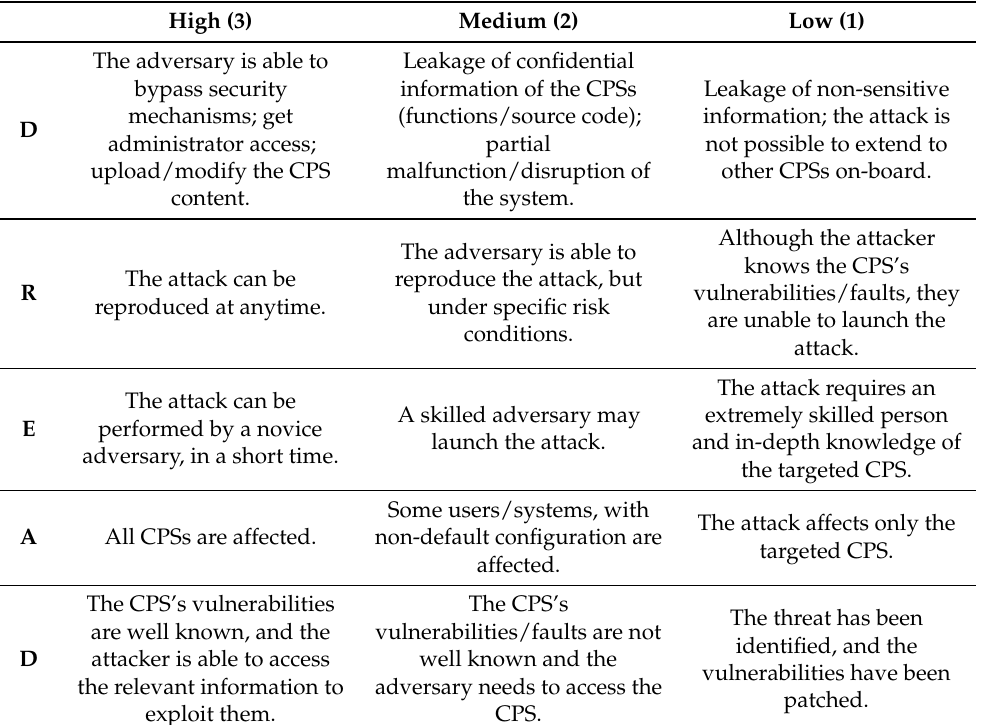
Table 1. Criteria for determining the values of the DREAD ( D amage, R eproducibility, E xploitability, A ffected, and D iscoverability) variables